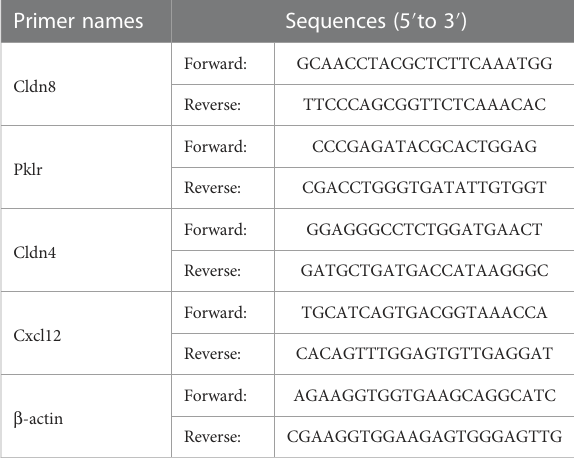
TABLE 1 The qPCR primer sequences involved in the